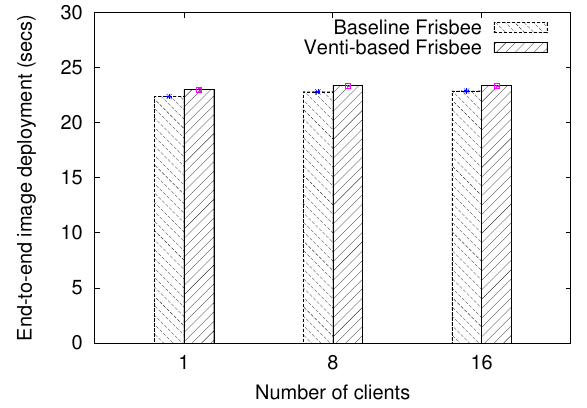
Figure 7: Average time to deploy an image to 1, 8, or 16 clients with synchronized start times